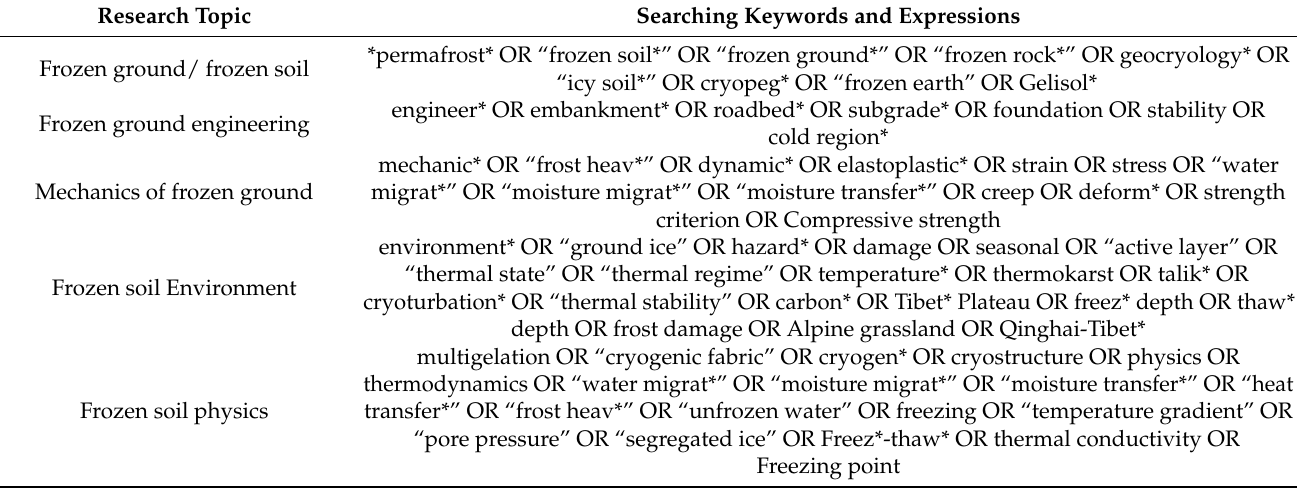
Table 9. Literature searching strategy related to frozen soil